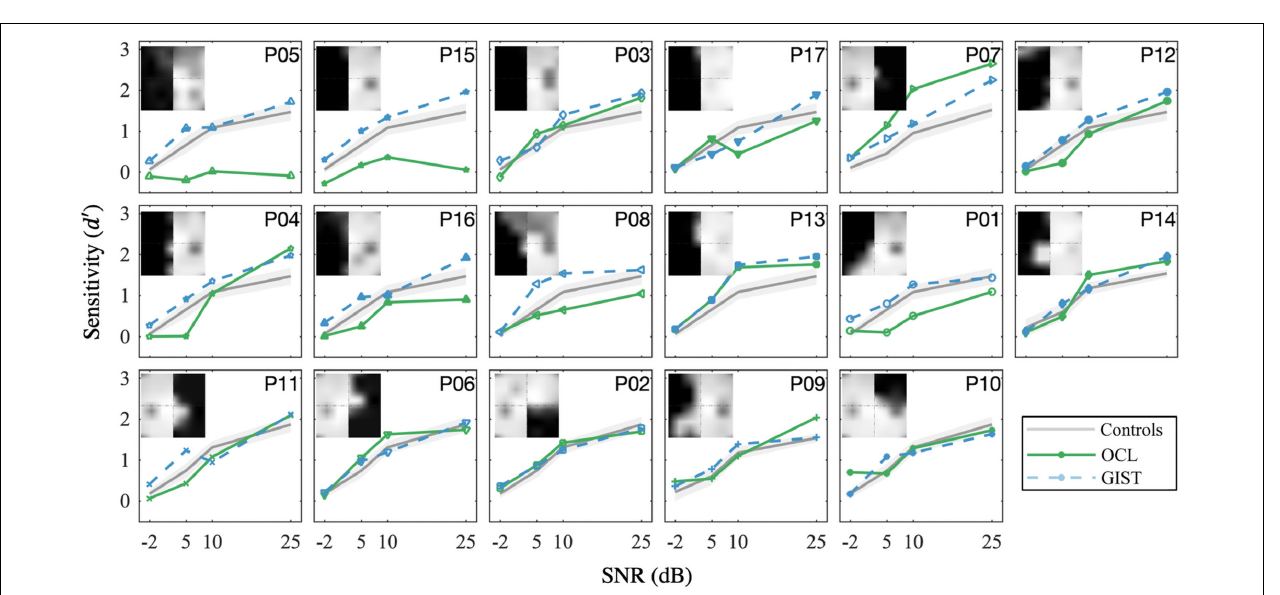
FIGURE 4 | OCL participants’ observed sensitivity ( d (cid:48) ) as compared with healthy controls crudely matches predicted sensitivity as well as the estimated sensitivity ( b d (cid:48) ) by the GIST model. Each panel shows OCL participants with their VFD, sorted by the Blind Field Index from the largest (P05) to the smallest (P10). Note that the performance of the OCL participants (greens) does not always correspond to the extent of the VFD, e.g., comparing participant P15 and P03. Error bars and shaded areas show the CI 95%